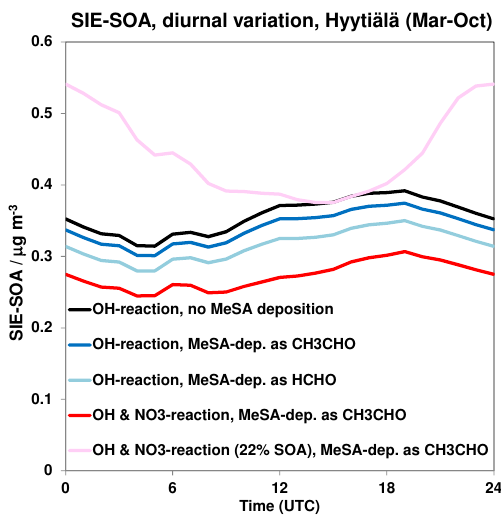
Figure 7. Modelled diurnal variation (average for the period Mar– Oct) of SIE-SOA at Hyytiälä using the Case 2 scenario for bi- otic stress-induced emissions, with different assumptions regard- ing MeSA deposition losses, NO 3 -reactivity and SOA-yield. Black curve: only OH reaction, no deposition of MeSA; dark blue: OH reaction, dry deposition of MeSA with the same deposition veloc- ity as acetaldehyde; light blue: OH reaction, wet and dry deposition of MeSA with the same treatment as formaldehyde; red: OH reac- tion, NO 3 reaction ( k = 5 . 4 × 10 − 13 cm 3 molecule − 1 s − 1 ), no SOA from MeSA+NO 3 reaction, dry depostion as acetaldehyde; pink: OH reaction, NO 3 reaction with 22% SOA-yield, dry depostion as acetaldehyde. Unit: µgm − 3